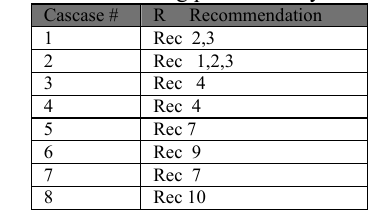
Table 6: General matching performed by TEKM